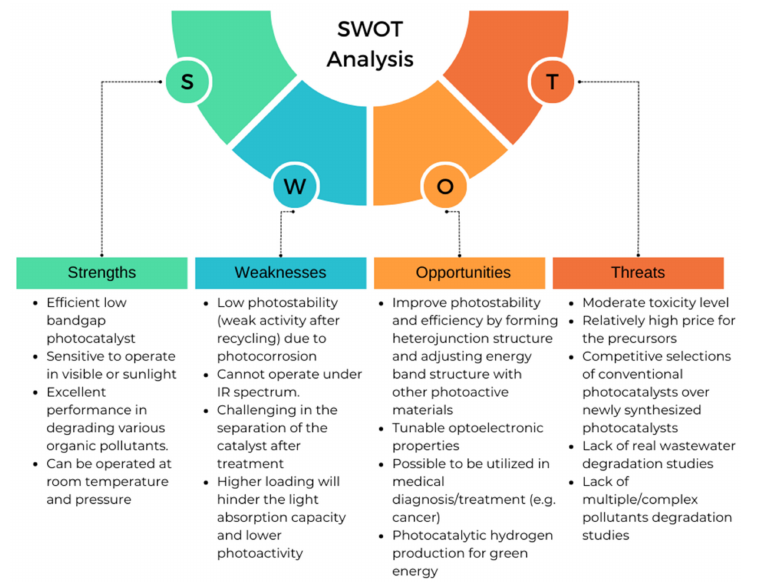
Figure 11. Prospect of Ag 2 CO 3 photocatalyst.